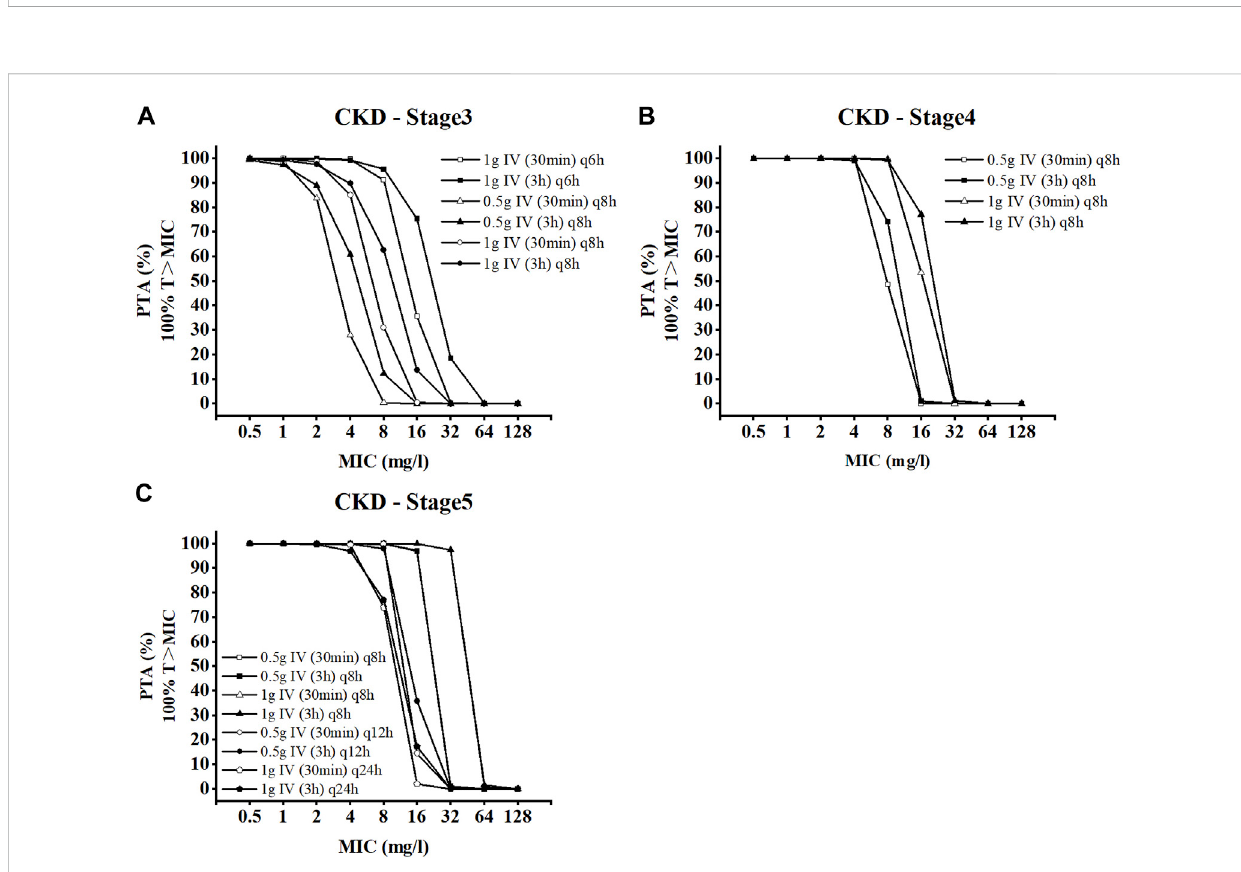
FIGURE 5 ProbabilityoftargetattainmentforCKDdoseregimensofmeropenemas3-hand30-mininfusions. (A) CKDstage3, (B) CKDstage4,and (C) CKDstage5.